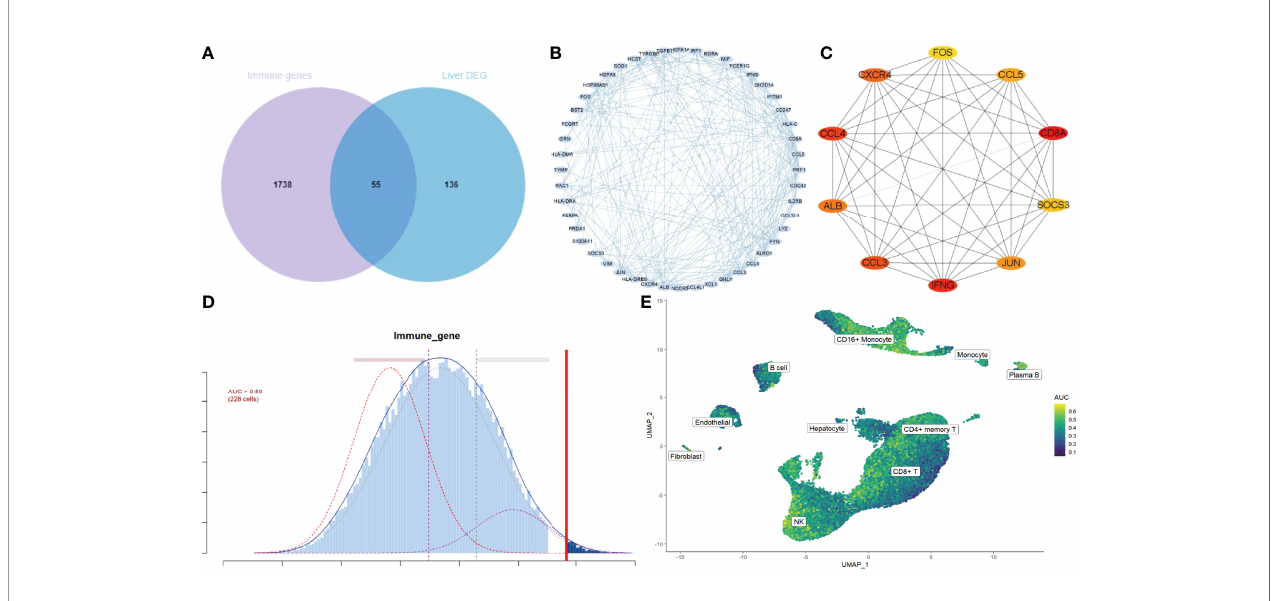
FIGURE 4 | IRGs and IRG scores of cirrhosis from scRNA sequencing data. (A) Venn plot showing IRGs of DEGs from the GSE136103 dataset and the gene set of the ImmPort database. A total of 55 IRGs were found. (B) The PPI network of the IRGs. (C) Results of the CytoHubba plugin and expanded the subnetwork. The color change from yellow to red was indicative of the rank of protein, where deeper red staining indicates higher protein rank. (D) Score of 55 IRGs. The threshold was chosen as 0.58. (E) UMAP plots of the IRG score in all clusters. CD16+ monocytes and NK cells express more genes and exhibit higher AUC